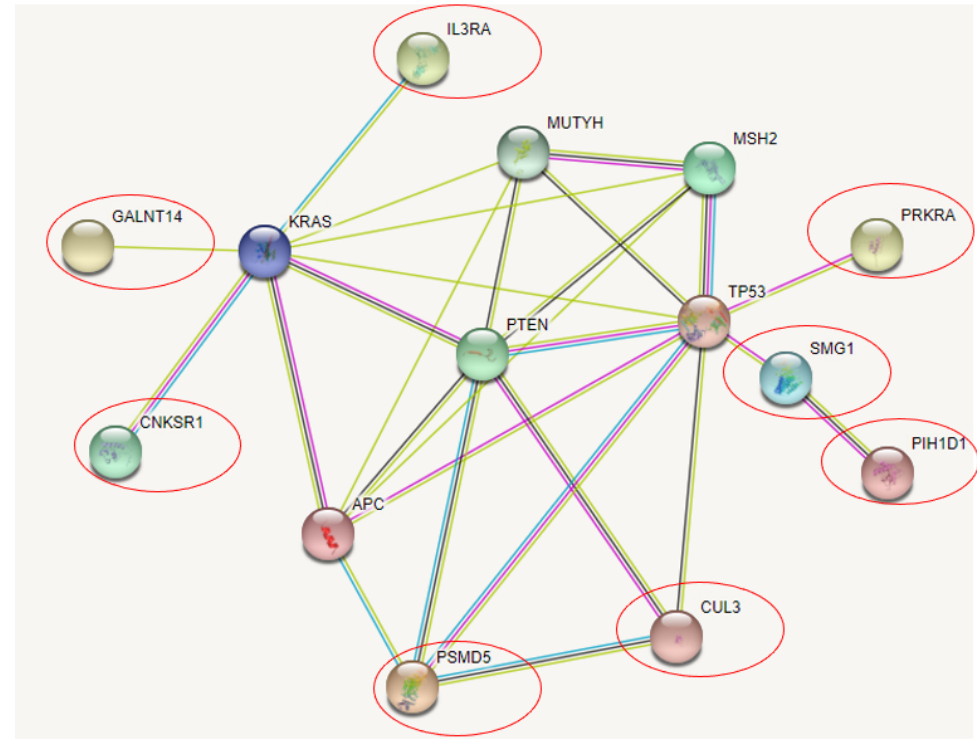
Figure 3. NCR genes and their association with CRC related genes in STRING.